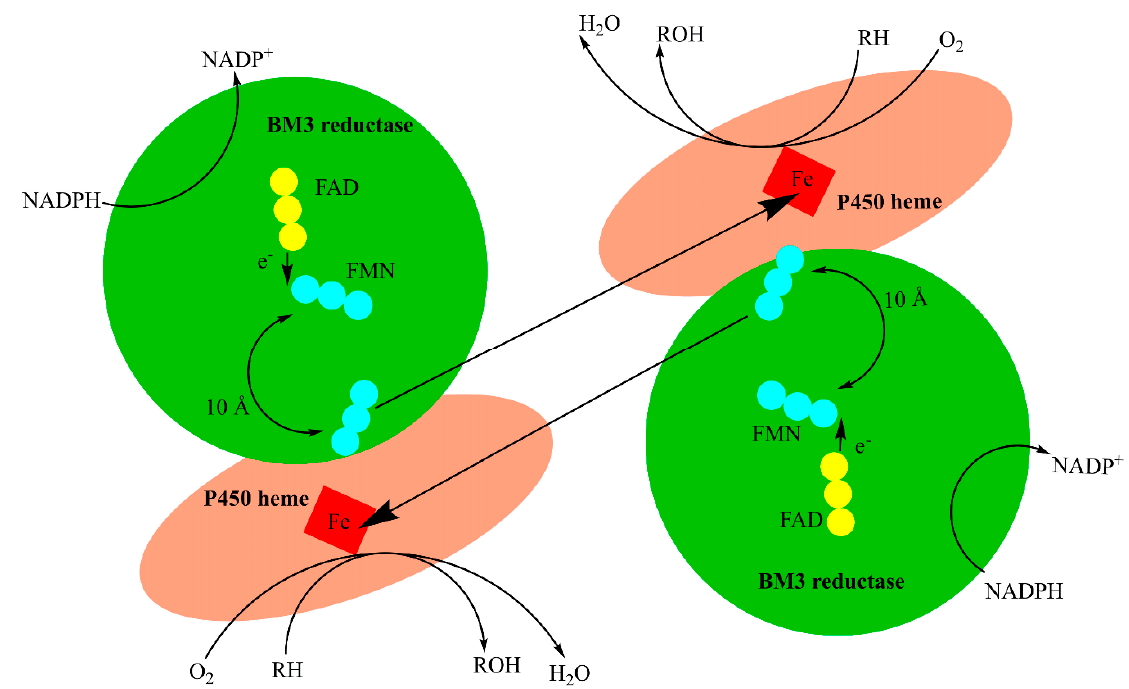
Figure 2. Hypothetical dimeric BM3 electron transfer. The flavin cofactors, FAD and FMN, facilitate electron transfer from the reductase domain to the heme domain. FAD (yellow circles) transfers electrons to FMN (blue circles, which then undergoes a structural rearrangement to facilitate electron transfer to the heme iron (red square).